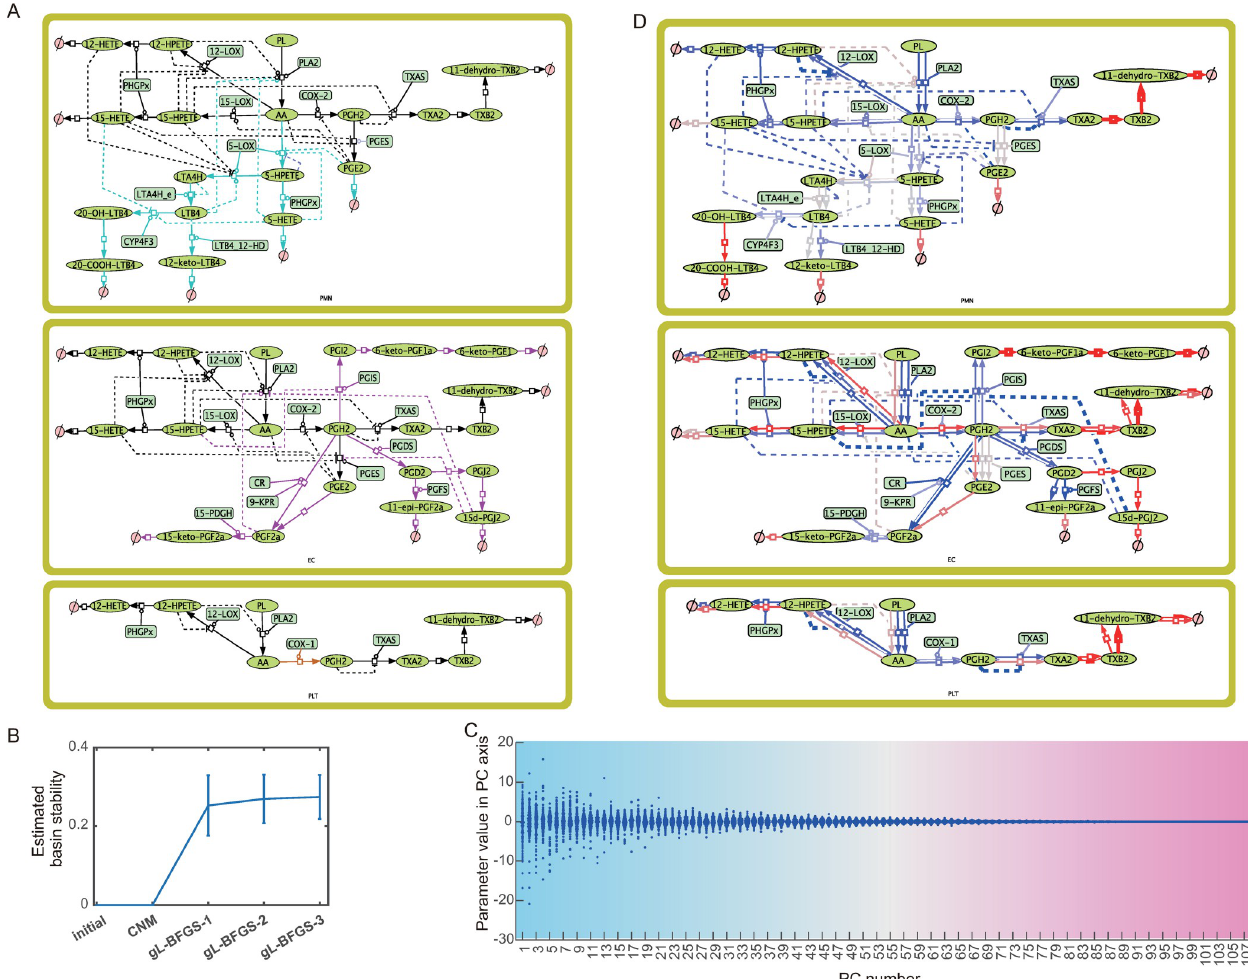
Fig 6. Utility of TEAPS in the analyses of arachidonic acid pathway model. (A) The model containing arachidonic acid pathways in polymorphonuclear cells (PMN), endothelial cells (EC), and platelets (PLT) was reconstructed according to the previously reported model structure. The Michaelis-Menten constants were set to the same values if there were same reactions in different cells. The reactions which only appears in each cell type are colored in cyan (PMN), pink (EC), and brown (PLT). The reactions with black arrows are shared with at least two cell types. For modifications on reactions, lines ending with a circle indicate promoting effect on a reaction whereas lines ending with a bar indicate inhibitory effect. Modificative effects by metabolite but not enzymes are described as dashed lines. (B) The estimated basin stability was increased by individual optimization process (gL-BFGS) when TEAPS were applied to the arachidonic acid pathway model. (C) The parameter sets obtained for the arachidonic acid pathway model were subjected to the principal component analysis. To figure out the entire shape of the parameter distribution, the number of components was set to the number of parameters in the model. (D) The reactions with tight and robust regulation were searched. Each arrow corresponds to each parameter on every reaction. The reactions related with parameters that appeared as high contribution to PCA axes in which the parameter distributions are narrow are colored in red, while those to each of the PCA axes in which the parameter distributions are broad are colored in